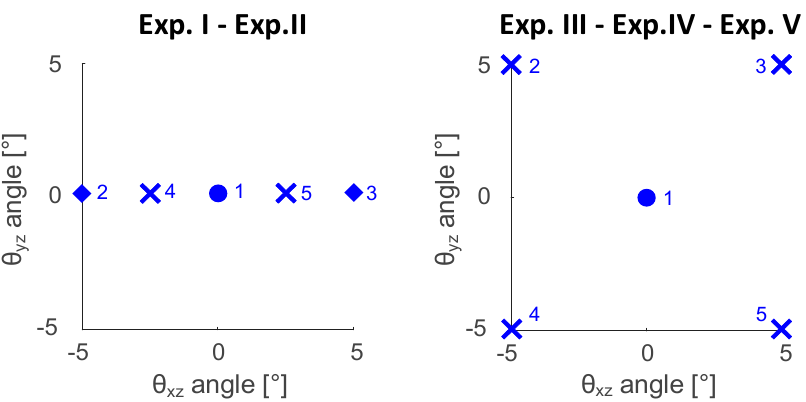
Figure 3. Virtual source steering angles set during the transmission of diverging waves. Left panel: in Experiments I and II, involving 2-D imaging sequences, the virtual sources were maintained over the imaging xz-plane; only the central source (dot) was used in DW1, two additional lateral virtual sources (diamonds) were used in DW3, and all the five virtual sources (dot, diamonds and crosses) were used in DW5. Right panel: in experiment III IV and V, only the central source (dot) was used for the scan sequence DW1; for the scan sequence DW5, the five sources (dot and crosses) were steered on both the xz and yz angle to ensure an homogeneous insonification of both lateral directions.